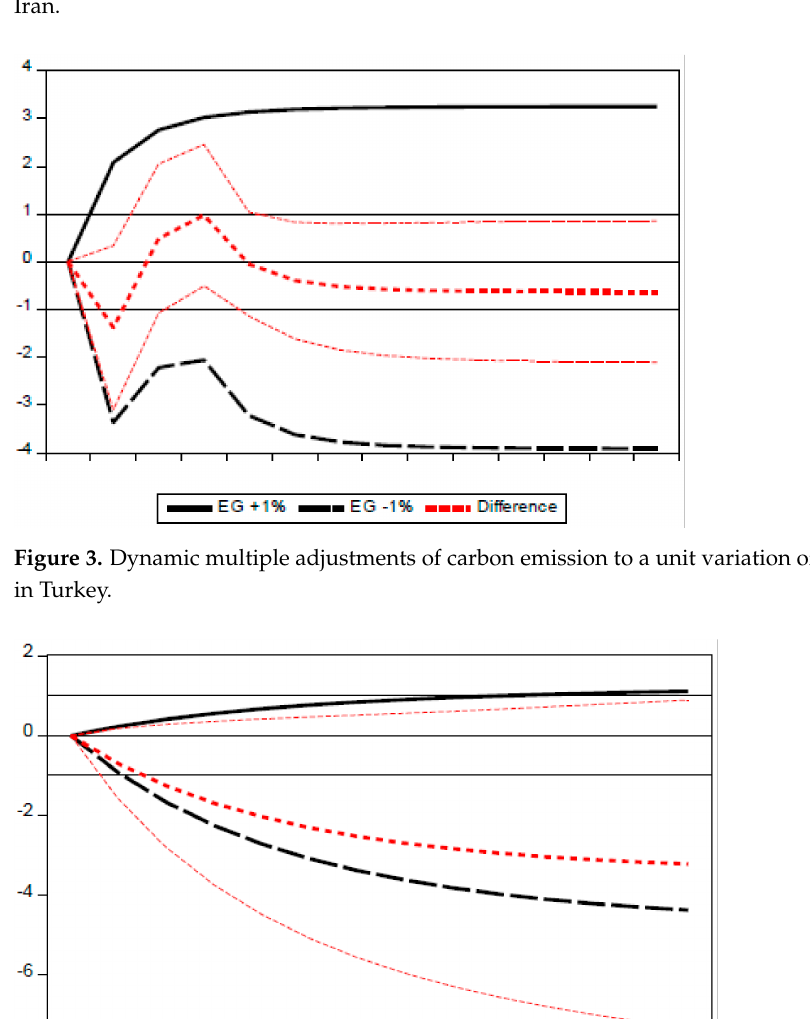
Figure 2. Dynamic multiple adjustments of carbon emission to a unit change in economic growth in Iran.